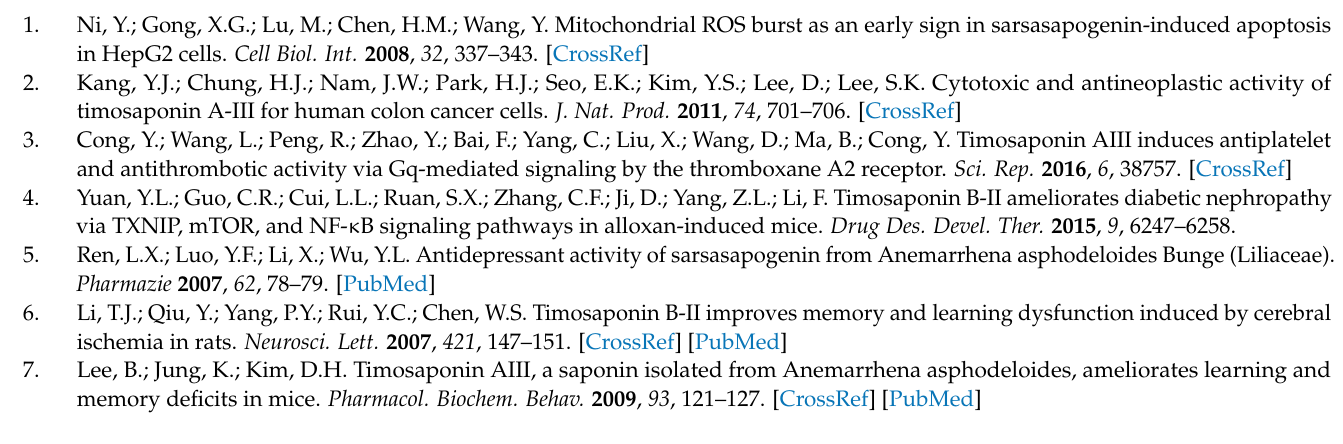
Figure S2: Representative standard curve of timosaponin BII (A), timosaponin AIII (B), timosaponin AI (C) and sarsasapogenin (D). Table S1: Method sensitivity and linear range of timosaponins; Table S2: Accuracy and recision of the method for determination of timosaponins (n = 5); Table S3: Recovery of the method for determination of timosaponins (n = 5); Table S4: Stability at room temperature for 4 h before treatment (n = 5); Table S5: Stability in the autosampler for 24 h at 4 ◦ C post-treatment (n =